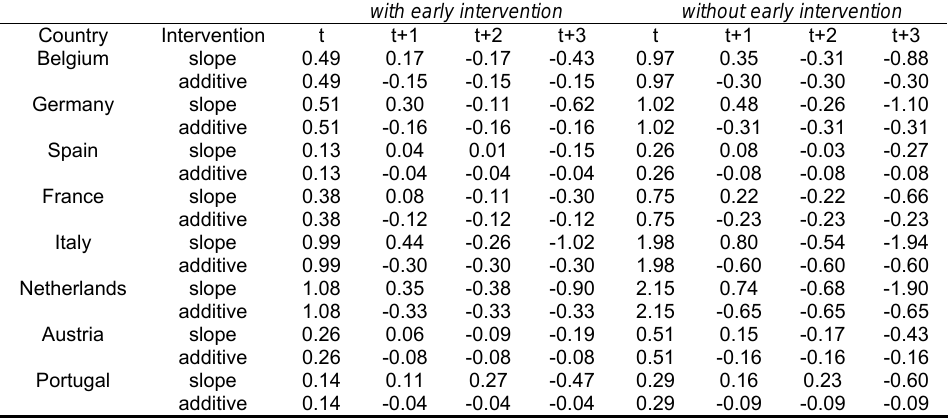
Table 14. The average changes in the fiscal impulse relative to the SP plan for the additive constant and the constant slope approaches with and without early interventions with early intervention